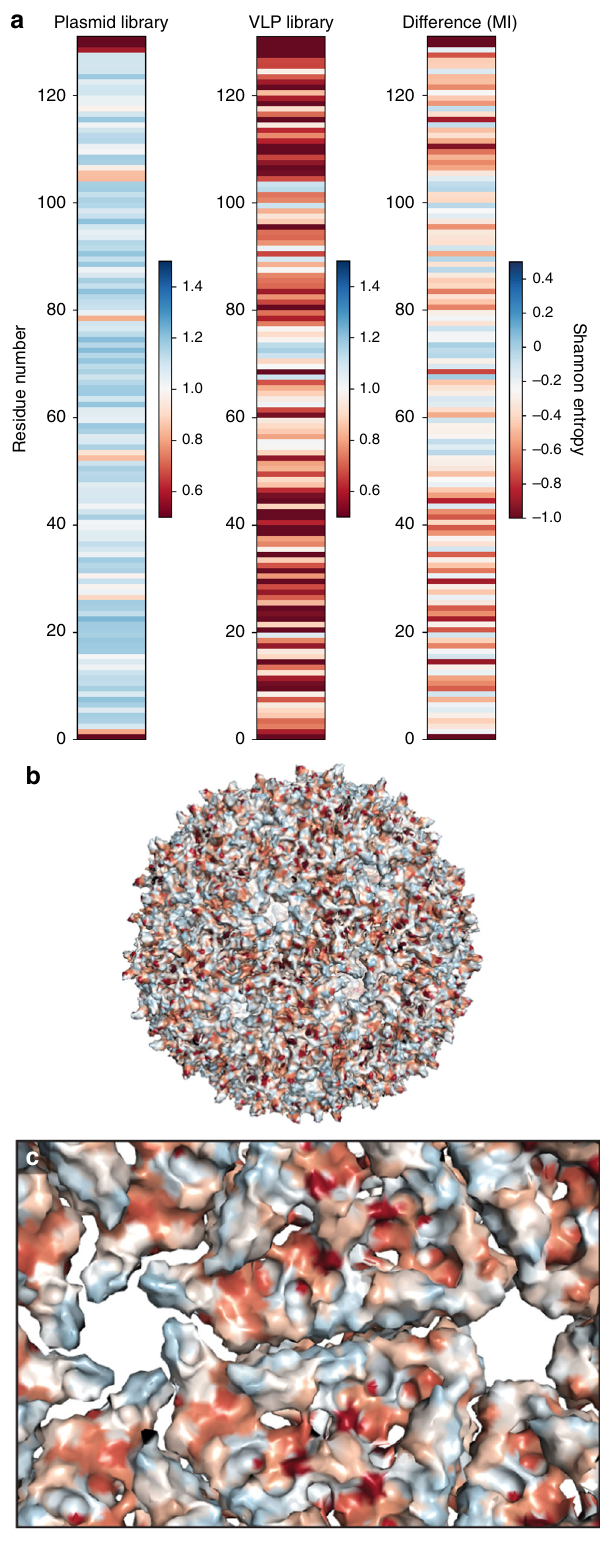
Fig. 4 Mutability of MS2 CP. a The Shannon entropy (SE) of the plasmid library and VLP library are shown, along with the Mutability index (MI, VLP SE — plasmid SE). b The MI is shown mapped onto assembled MS2 CP (PDB ID = 2MS2) using the same coloring scheme as part A. c The MI is also shown from the interior perspective of assembled MS2